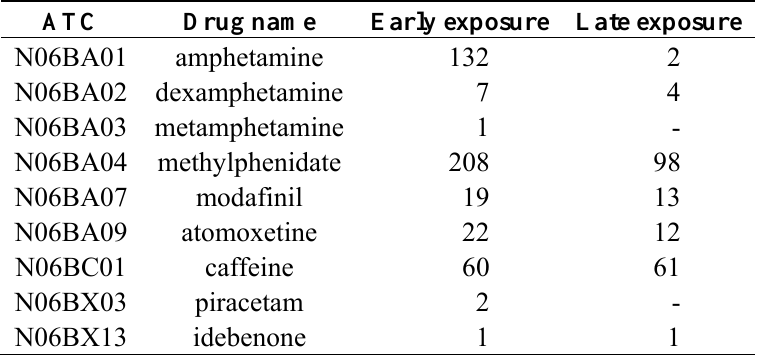
Table 38. Number of infants exposed in early pregnancy to psychostimulants. ATC Drug name Early